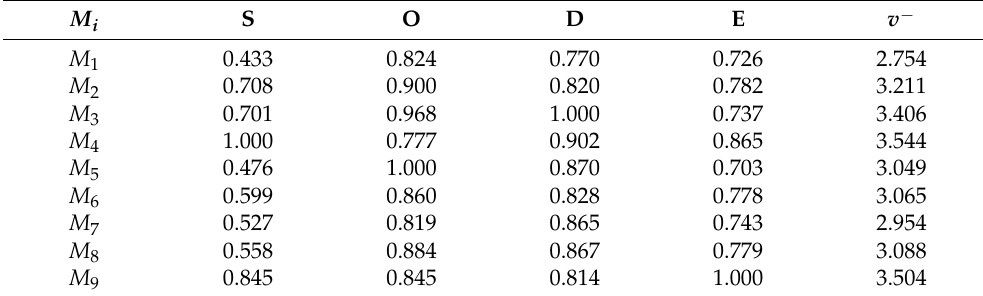
Table 11. The gray correlation coefficient of the failure mode i in relation to the negative ideal solution